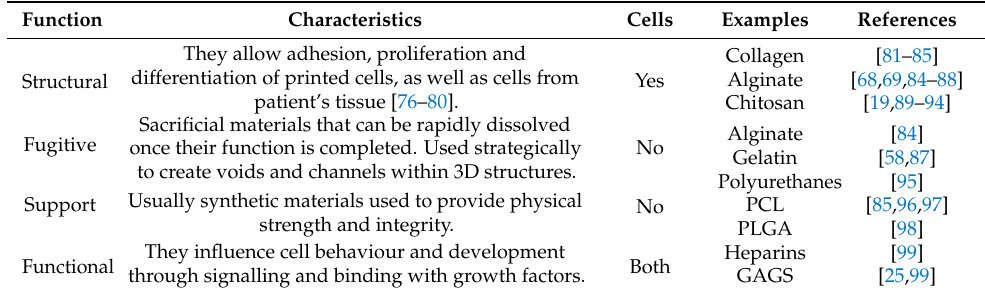
Table 1. Table summarising different bioink components according to their function and characteris- tics they provide in bioprinted tissues. (PCL: Polycaprolactone, PLGA: Poly lactic co-glycolic acid, GAGs: